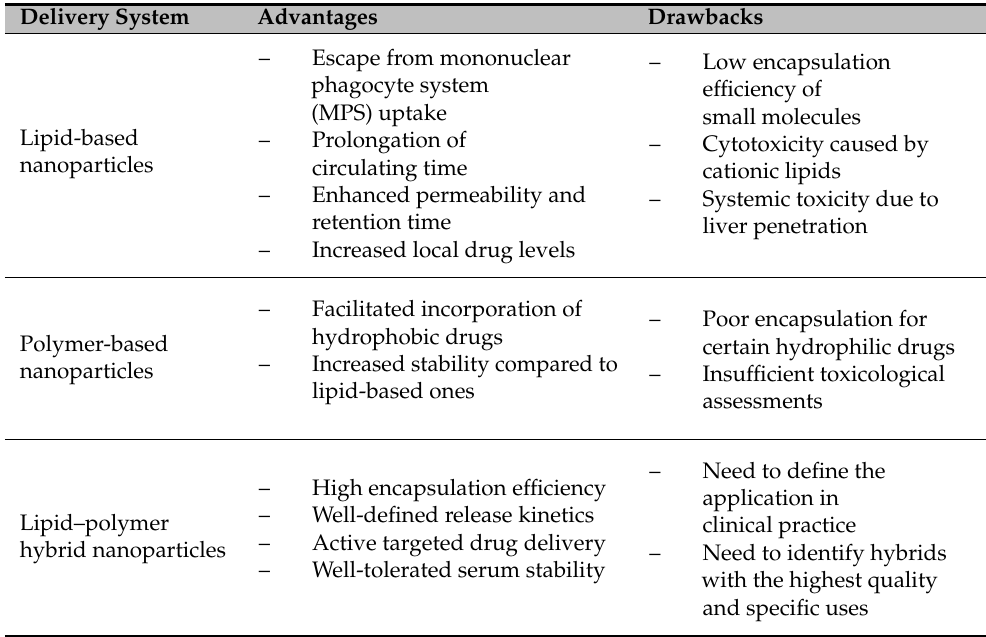
Table 2. Nanoparticle-based delivery systems: examples of advantages and